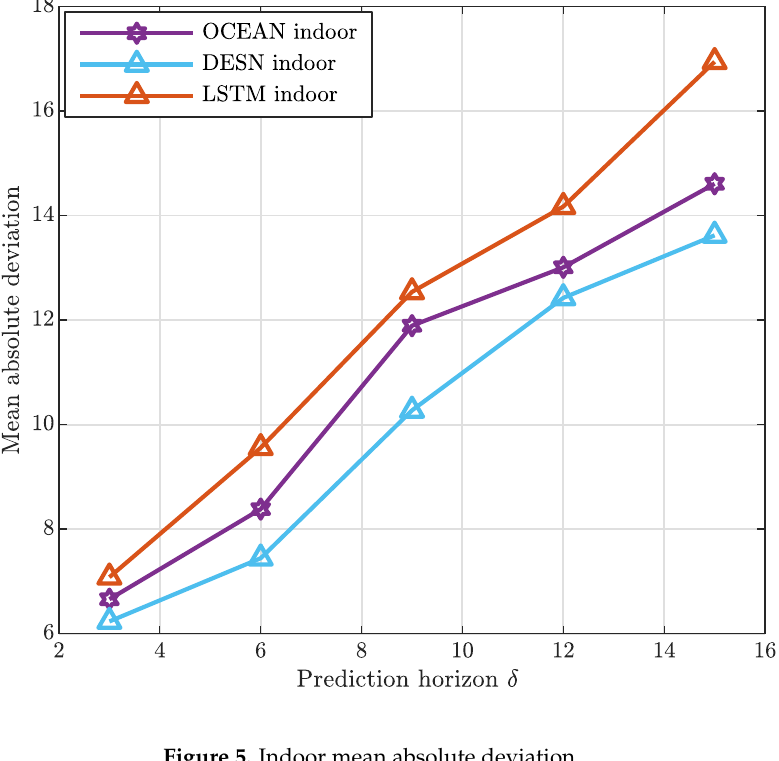
Figure 5. Indoor mean absolute deviation.